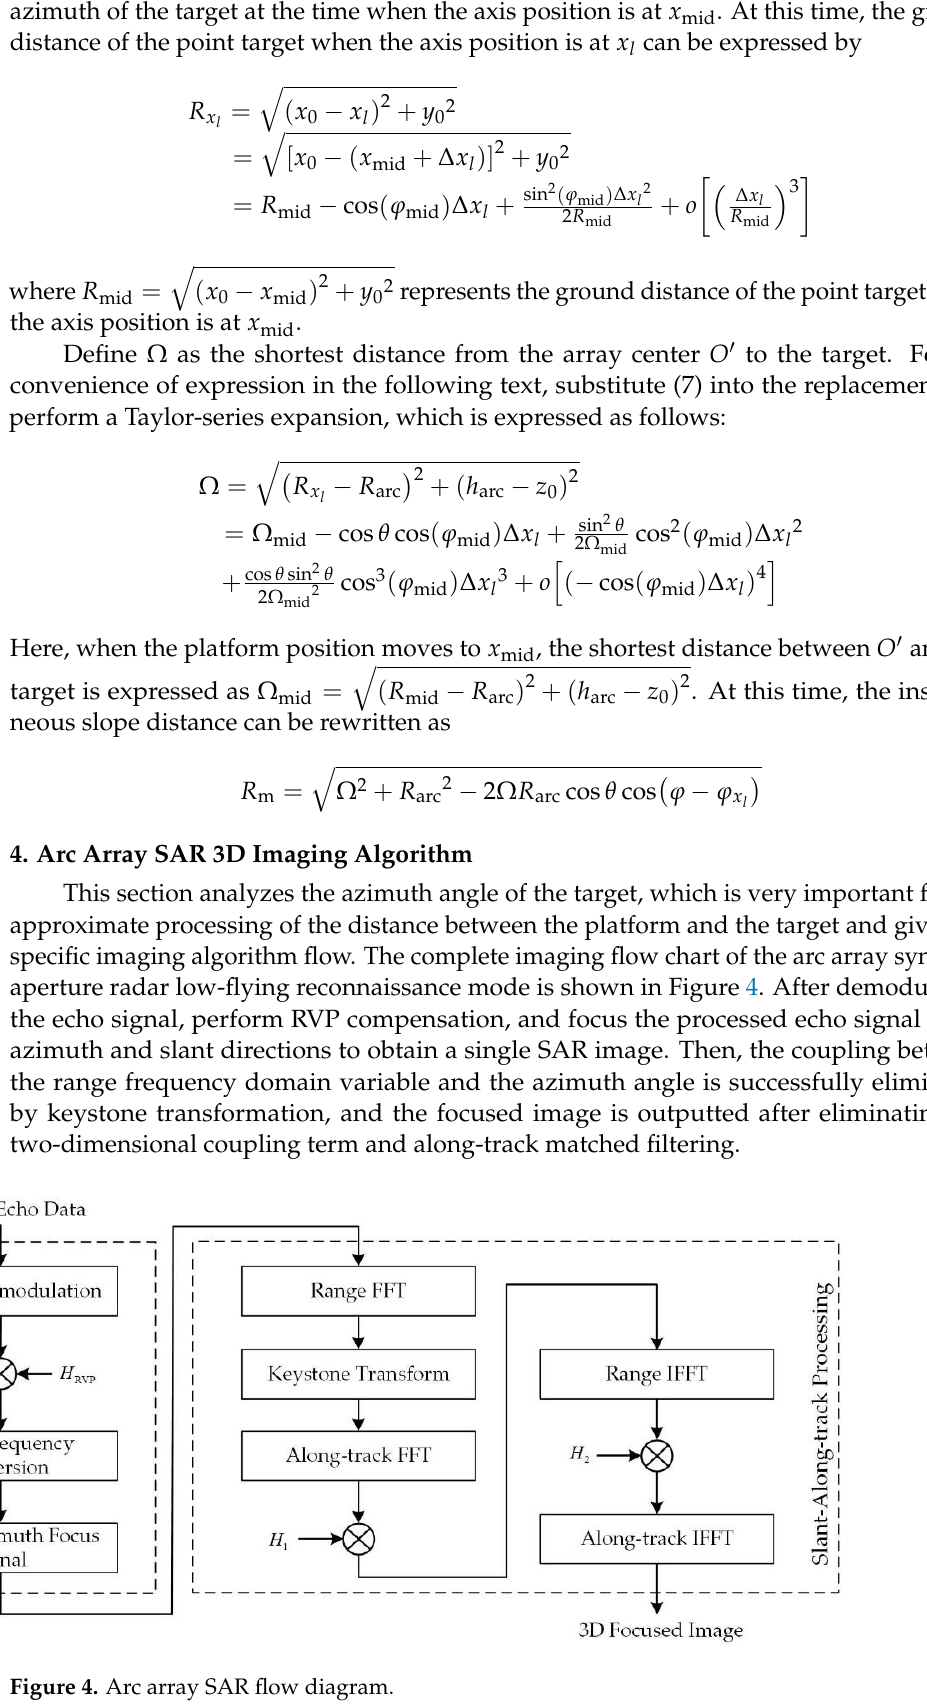
Figure 4. Arc array SAR flow diagram.